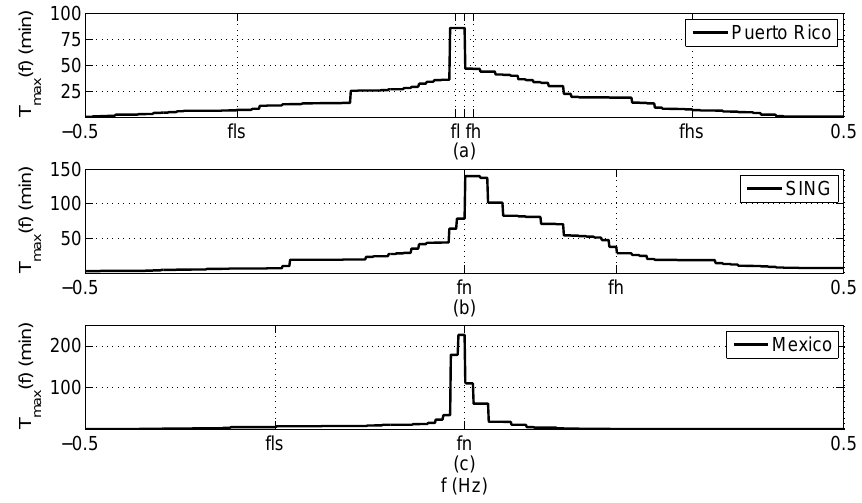
Figure 7. Maximum clearing time of frequency excursions in three different power grids: ( a ) Puerto Rico (PREPA); ( b ) Chile (SING); and ( c ) Mexico (CFE).